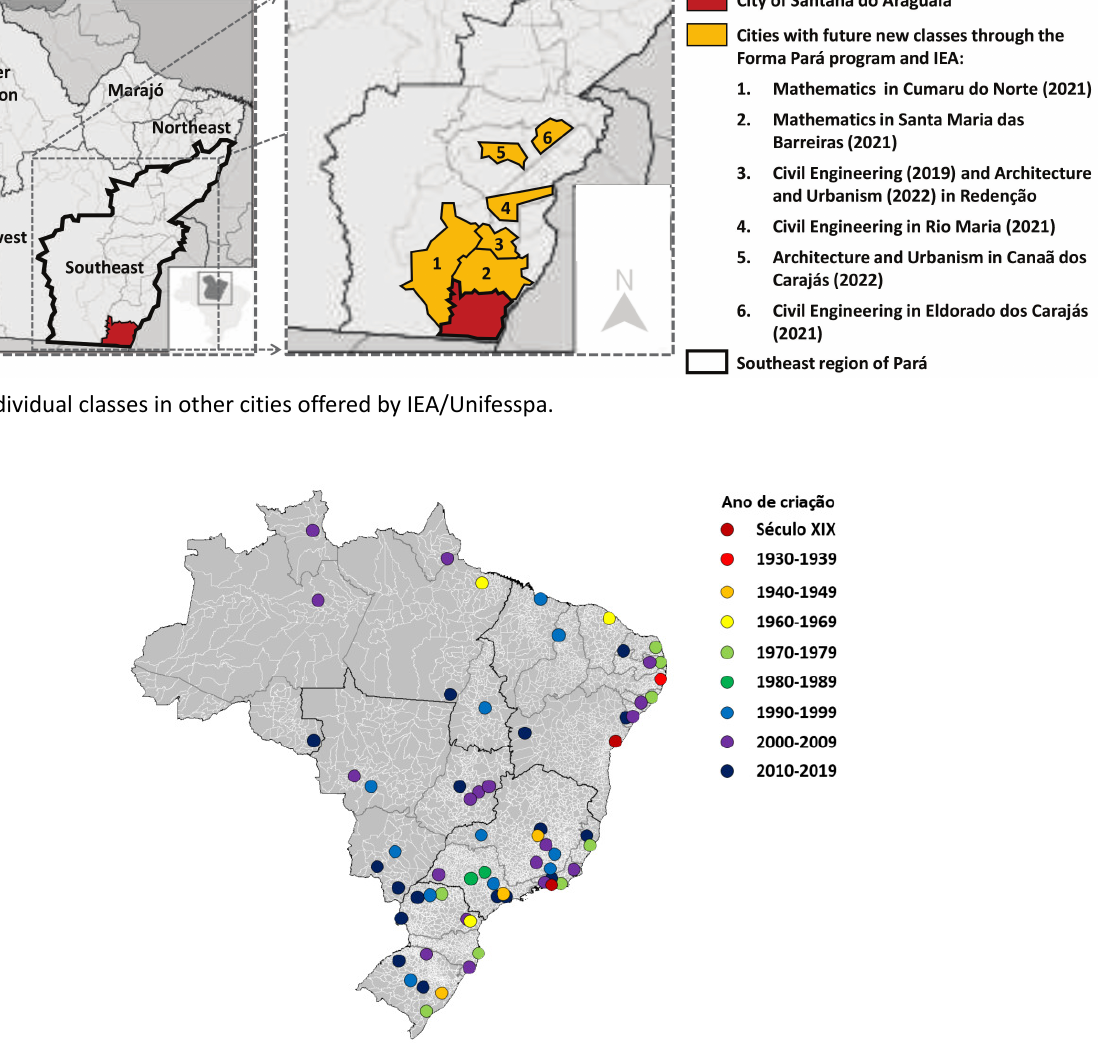
Figure 7. Map of architecture and urbanism courses by year of creation since the 19th century. Source: Simas et al. (2021).